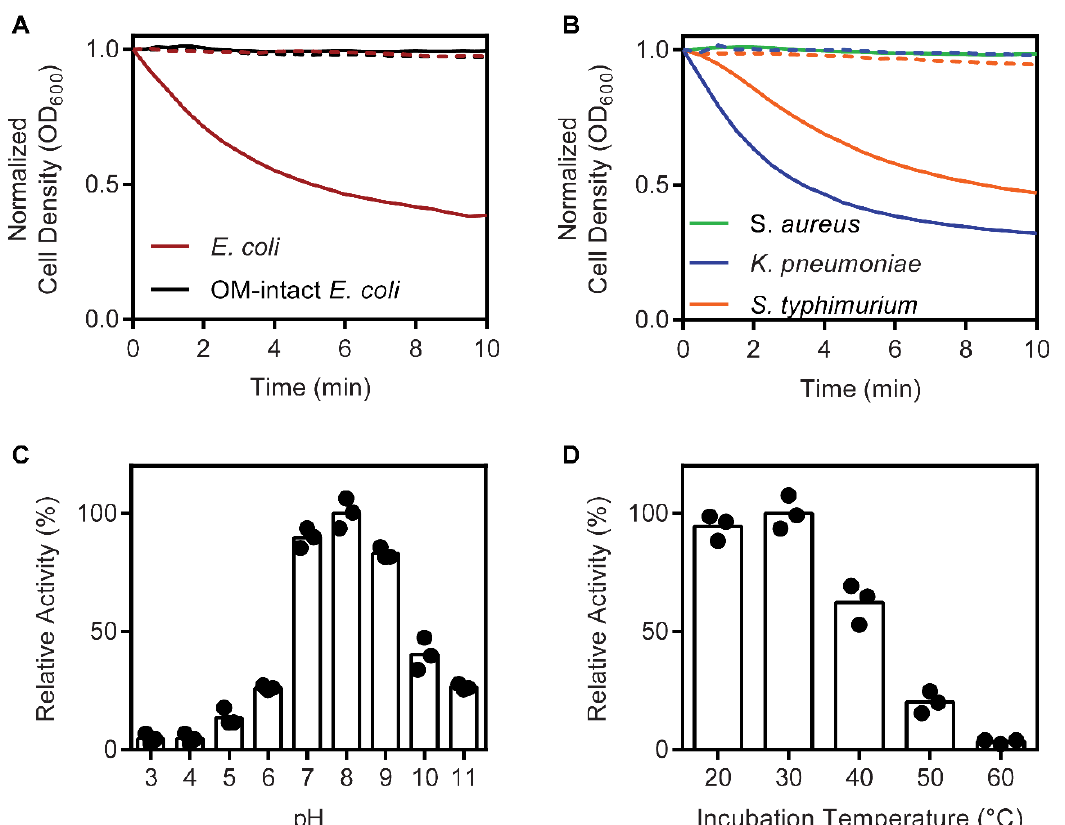
Figure 2. LysF1 is an active endolysin. ( A ) The incubation of LysF1 with outer membrane-permeabilized E. coli (red) resulted in a decrease in optical density (OD 600 ) indicating lysis is occurring as a result of peptidoglycan degradation. Lysis was not observed when LysF1 was incubated with E. coli that had intact outer membranes (OM) (black). ( B ) LysF1 was also active against outer membrane-permeabilized K. pneumoniae (blue) and S. typhimurium (orange). LysF1 was not active against S. aureus (green) with no reduction in optical density measured. Dashed lines show the optical density of each cell suspension without the addition of protein. ( C ) The pH dependence of LysF1 activity measured against cells resuspended in different pH buffers. ( D ) The residual activity of LysF1 measured after 30 min incubation at each temperature. Activity is plotted relative to the highest measured activity.